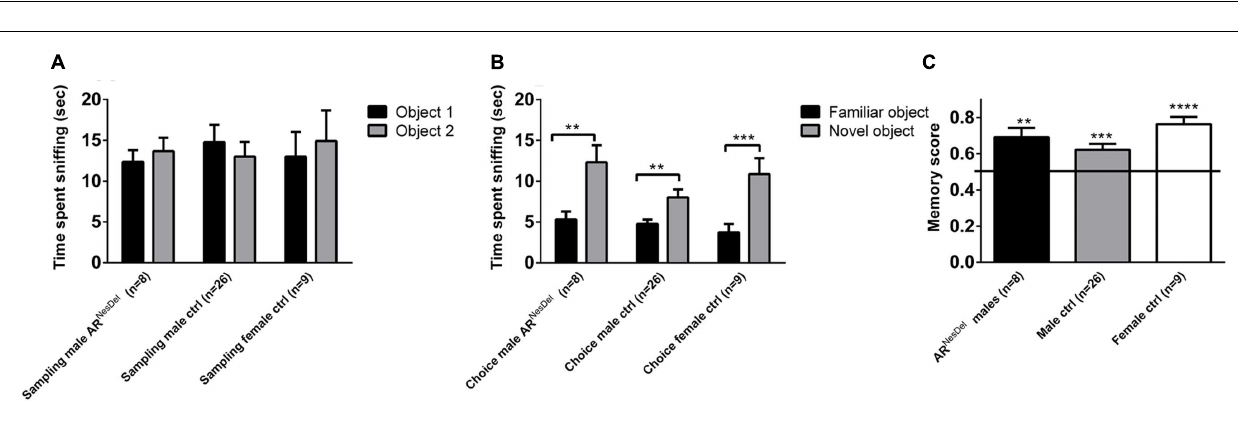
FIGURE 4 | Novel object recognition (NOR) memory test in AR NesDel males, male controls (wildtype, AR flox , NesCre + / − ), and female controls (ARflox + / − ). (A) Amount of time spent sniffing two similar objects. (B) Amount of time sniffing a familiar object or a novel. (C) Object memory score. Bars represent mean ± SEM, ∗∗ p < 0.01, ∗∗∗ p < 0.001, ∗∗∗∗ p < 0.0001 (for within-group